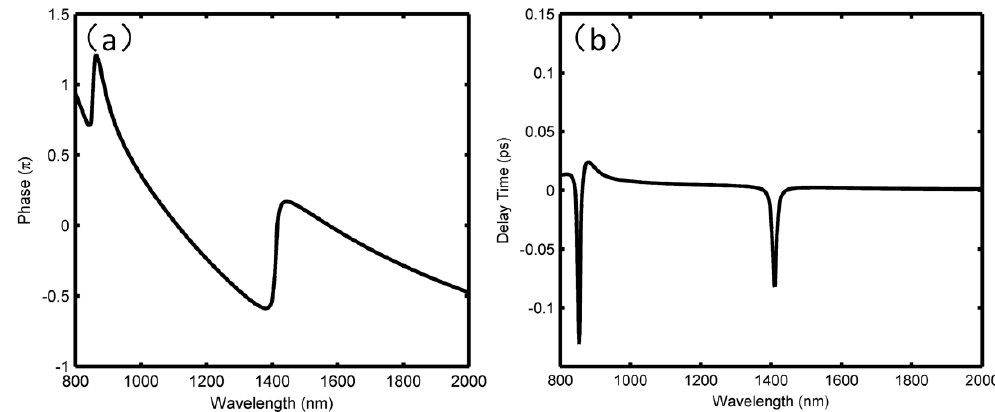
Figure 3. ( a ) Phase responses; and ( b ) delay time for the double ring resonator structure,